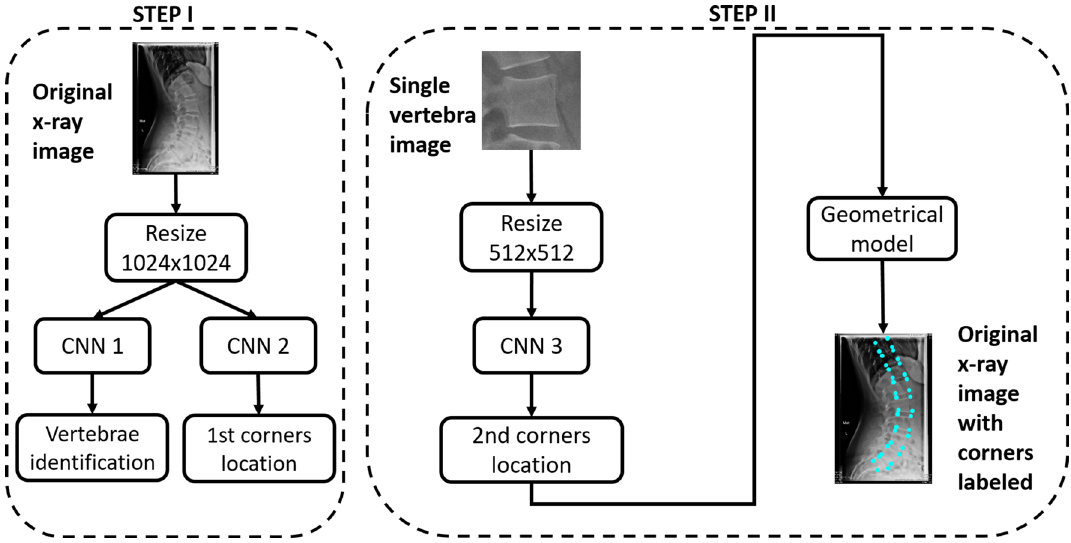
Figure 10. 2-step model. The output of each step is the input of the next step. In a real-world setting, the user must only input the original x-ray image and the model will automatically calculate the coordinates of the